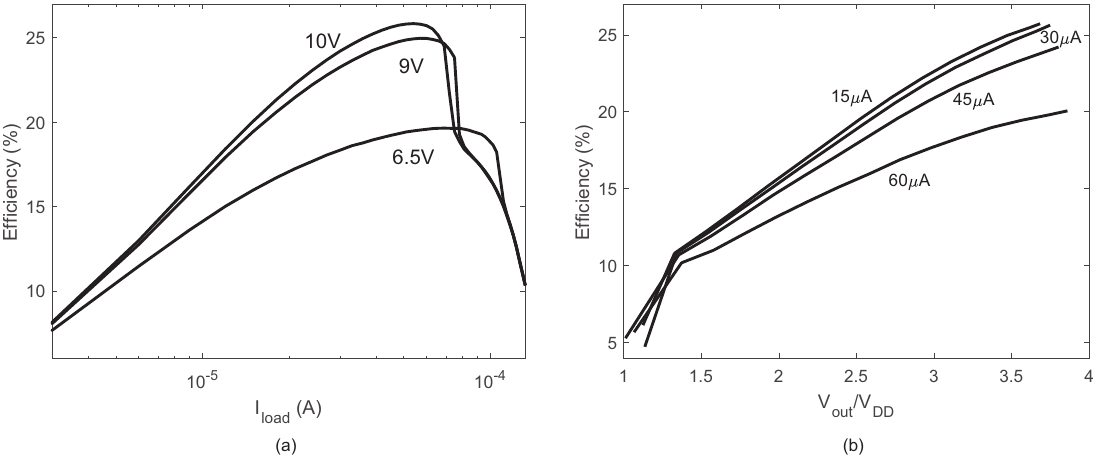
Figure 11. ( a ) Measured efficiency of the proposed charge pump vs. I L . ( b ) Measured efficiency of the proposed charge pump vs. V out / V dd .